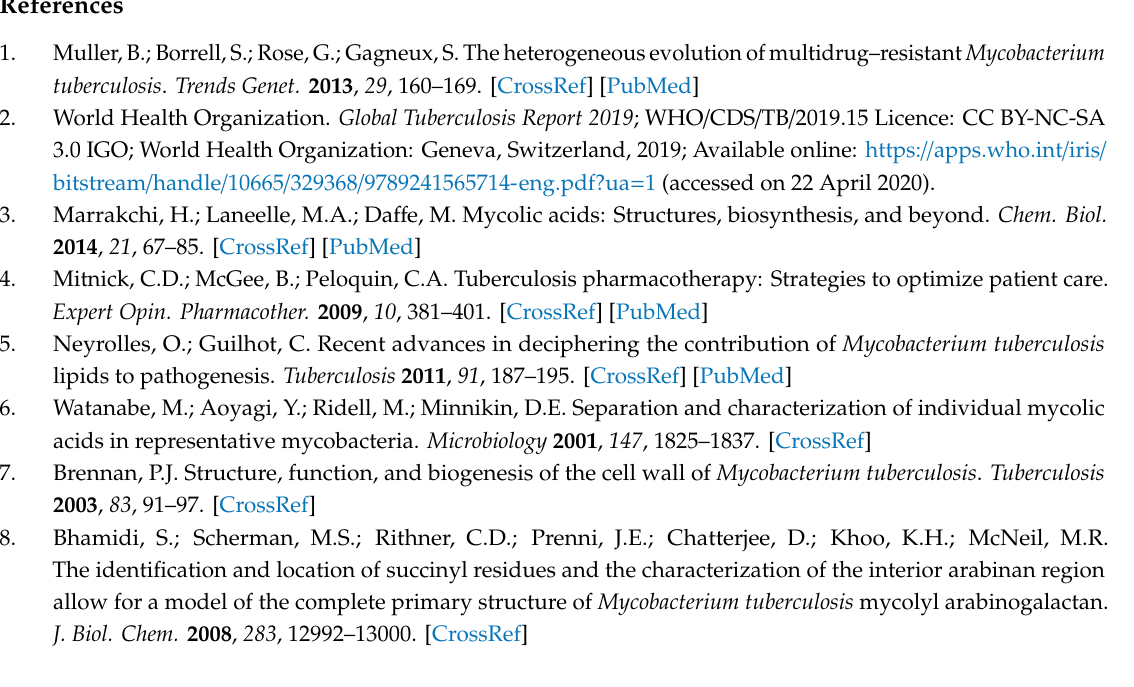
Figure S1: SDS-PAGE of purified LysB-His 6 enzymes. L1 Precision Plus Protein TM All Blue Prestained Standards (Bio-Rad), L2: LysB-D29 (MW: 29.3 kDa), L3: LysB-Omega (MW: 31.5 kDa), L4: LysB-Saal (MW: 37.4 kDa), L5: LysB-Obama12 (MW: 36.7 kDa). Figure S2. Nucleotide sequences of the codon optimized genes used in the current study. Figure S3: 3D conformations of poses of p NP ligands upon docking to LysB proteins. Each diagram illustrates (in order) the overall surface of protein with its ligand, the shape of active site with the docked ligand, the interactions of ligand atoms with di ff erent residues of the corresponding protein. Hydrophilic residues (pink color), hydrophobic residues (green color), p NP ligands (black color). Orientation pose: ligand-protein conformation where the catalytic Ser faces ligand’s ester bond (C = O) with no H-bond formation. NDP: (No Detected Pose) neither binding nor orientation pose were detected. Stars indicate catalytic triad residues of LysB-D29. Table S1: Minimum Inhibitory Concentration (MIC) and Minimum Bactericidal Concentration (MBC) values of the antibiotics used in the antibacterial activity assay against M.